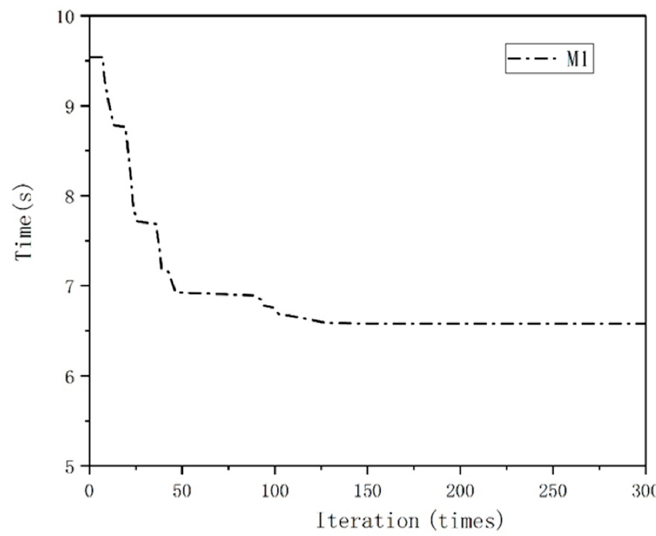
Figure 7. Time iterative curve of lathe.